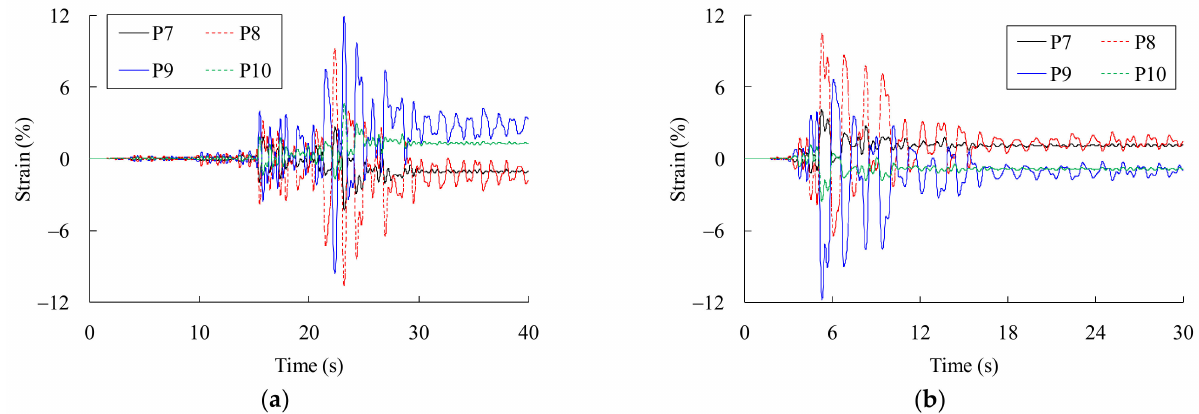
Figure 16. Strain responses of the joints under strong earthquakes: ( a ) Strain responses caused by Chi-chi earthquakes; ( b ) strain responses caused by Niigata earthquakes.